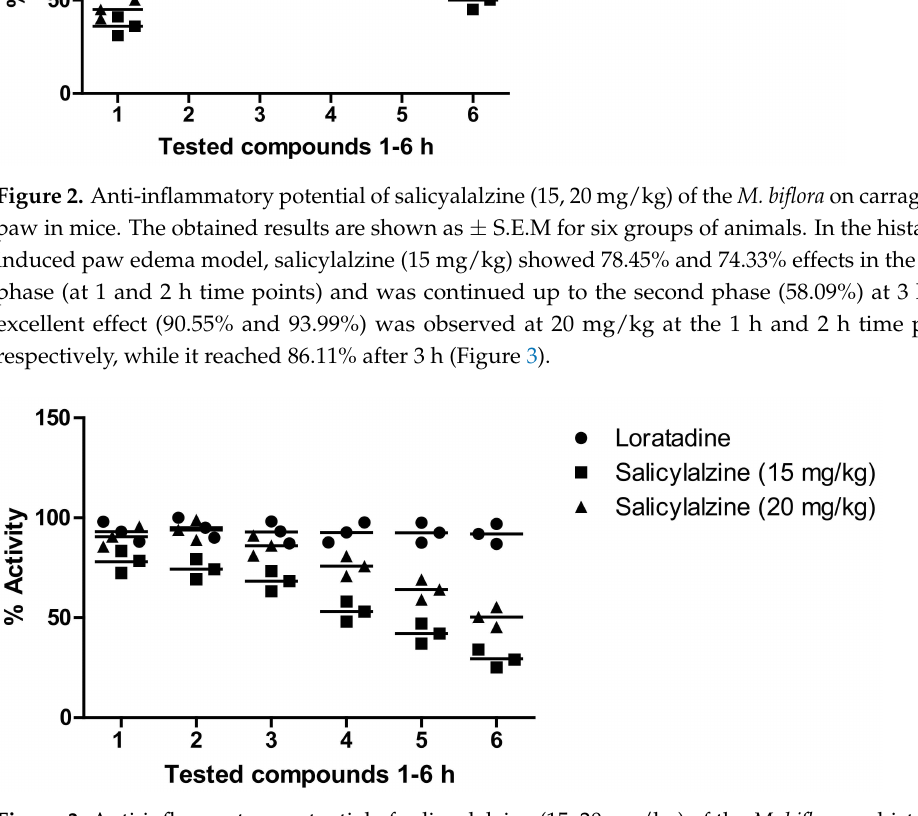
Figure 3. Anti-inflammatory potential of salicyalalzine (15, 20 mg/kg) of the M. biflora on histamine- induced paw in mice. The obtained results are shown as mean ± S.E.M for six groups of